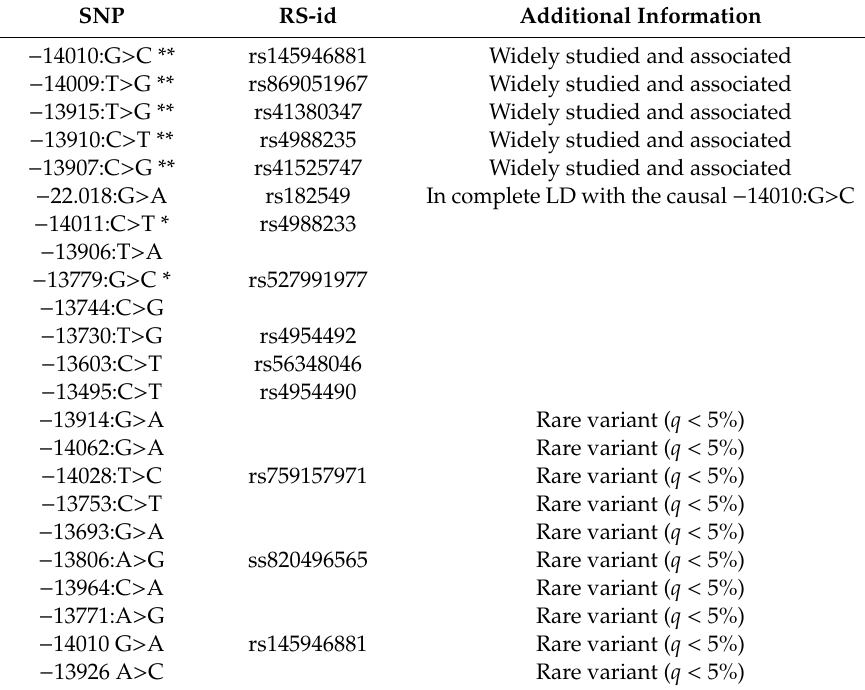
Table 1. Lactase persistence (LP)-associated genetic variants in the